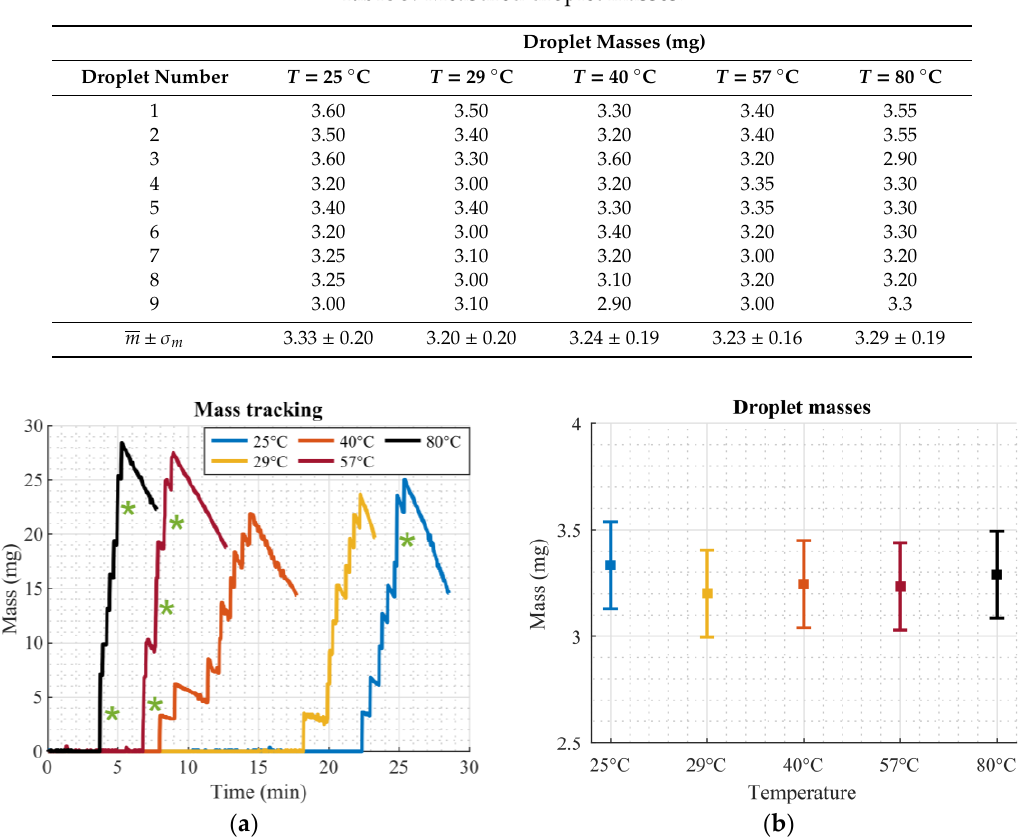
Figure 8. Droplet mass measurements at different heater temperatures. ( a ) Tracked mass for different temperatures. Jumps in mass correspond to droplets impinging on the scale. Green asterisks (*) indicate two droplets impinging on the scale almost simultaneously. ( b ) Error bar plot of droplet masses at different temperatures. Squares show the mean value, error bars show the standard deviation from Table 3.